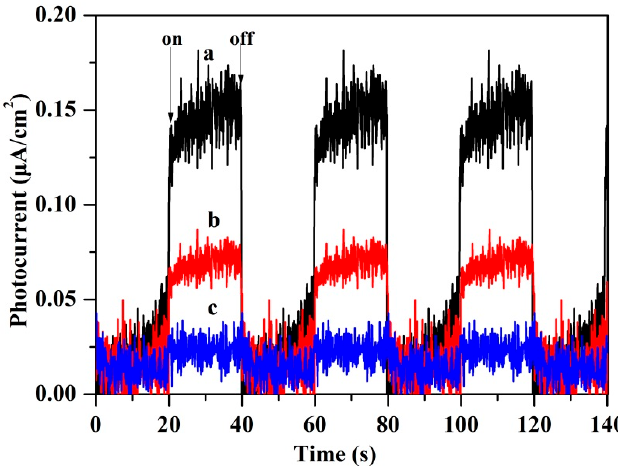
Figure 8. Photocurrent responses of ( a ) NTNT, ( b ) TNT, and ( c ) K 3 Ti 5 NbO 14 .